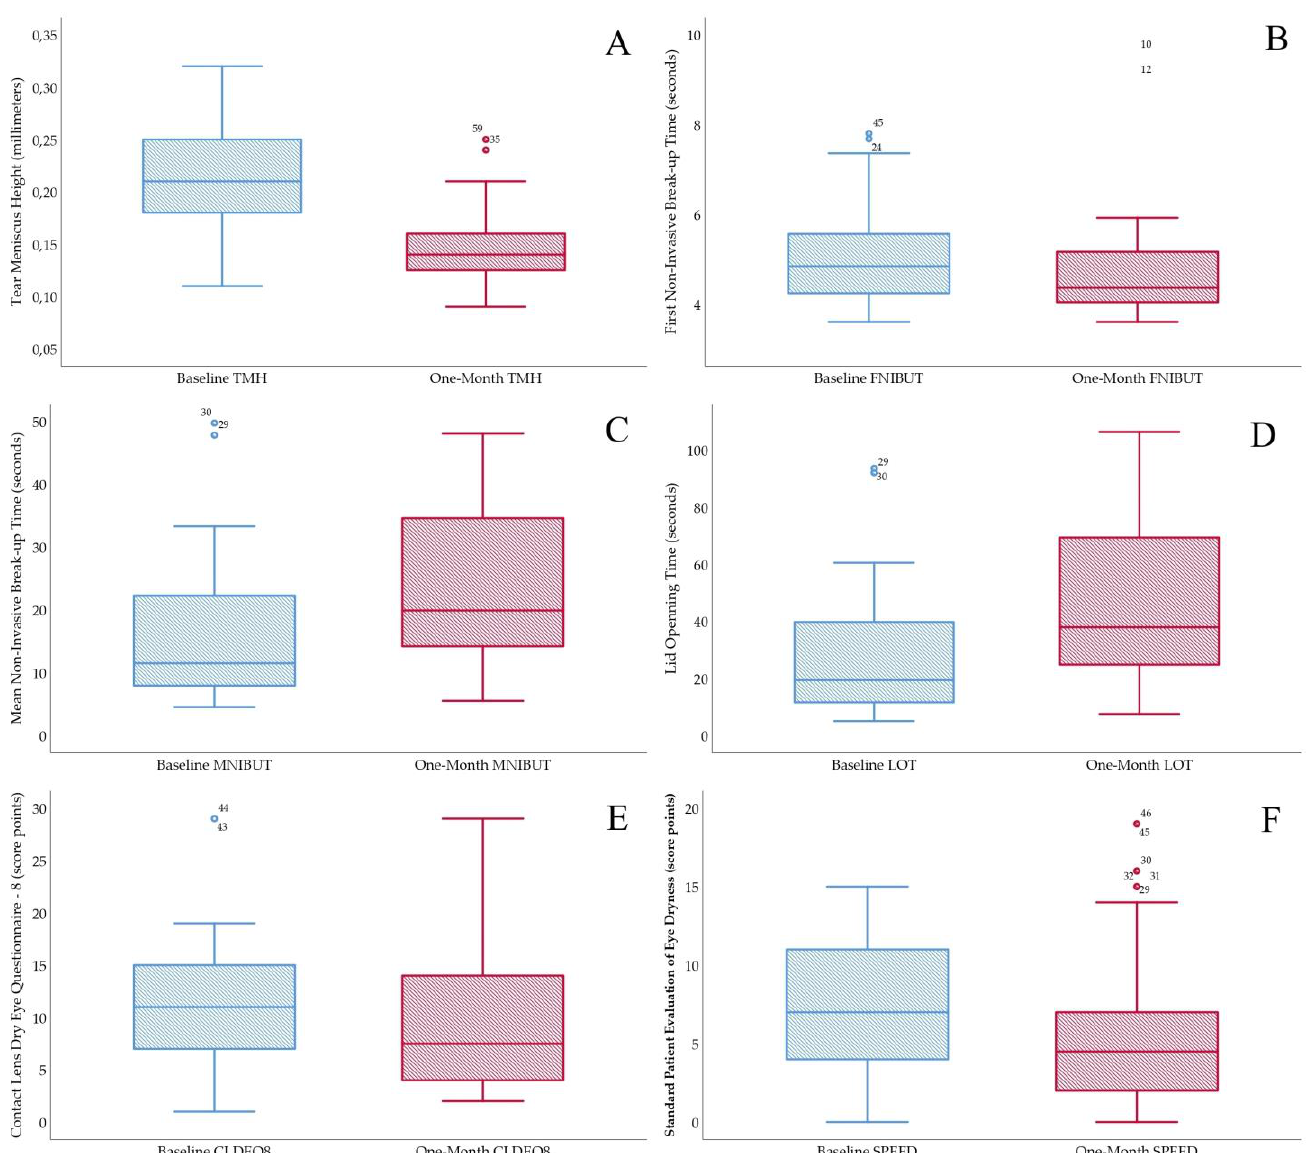
Figure 3. Box & Plot longitudinal changes before and one month after contact lens wear. ( A ): Tear meniscus height, ( B ): First NIBUT, ( C ): Mean NIBUT, ( D ): LOT, ( E ): CLDEQ8 and ( F ): SPEED.